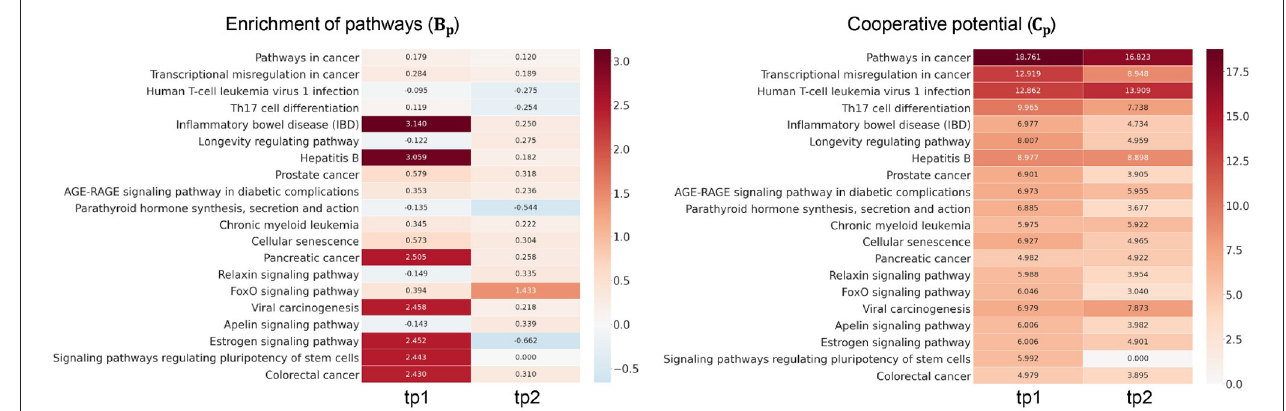
FIGURE 3 | Examination of transcription factor (TF) cooperation. High score of B p and C p represents the amount of cooperativity of co-working TFs in the pathways. Heatmap in the left panel shows the cooperation in terms of pathway enrichment over time in high-fat meal (HFM). Pathway enrichment in the G all was compared to the simulations given each TF ( G i ) and measured using Equation (5). Heatmap in the right panel shows the cooperative potential using enriched pathway genes. Betweenness centrality was compared between G all and G i using Equation